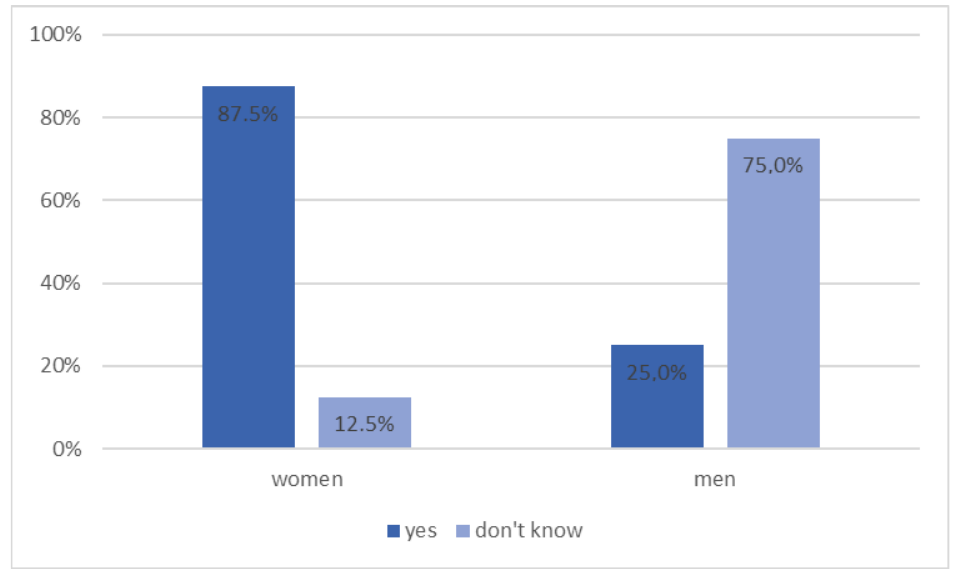
Figure 11. Diabetic patients’ interest in pharmaceutical care services in diabetology by gender ( n = 12, p = 0.029).